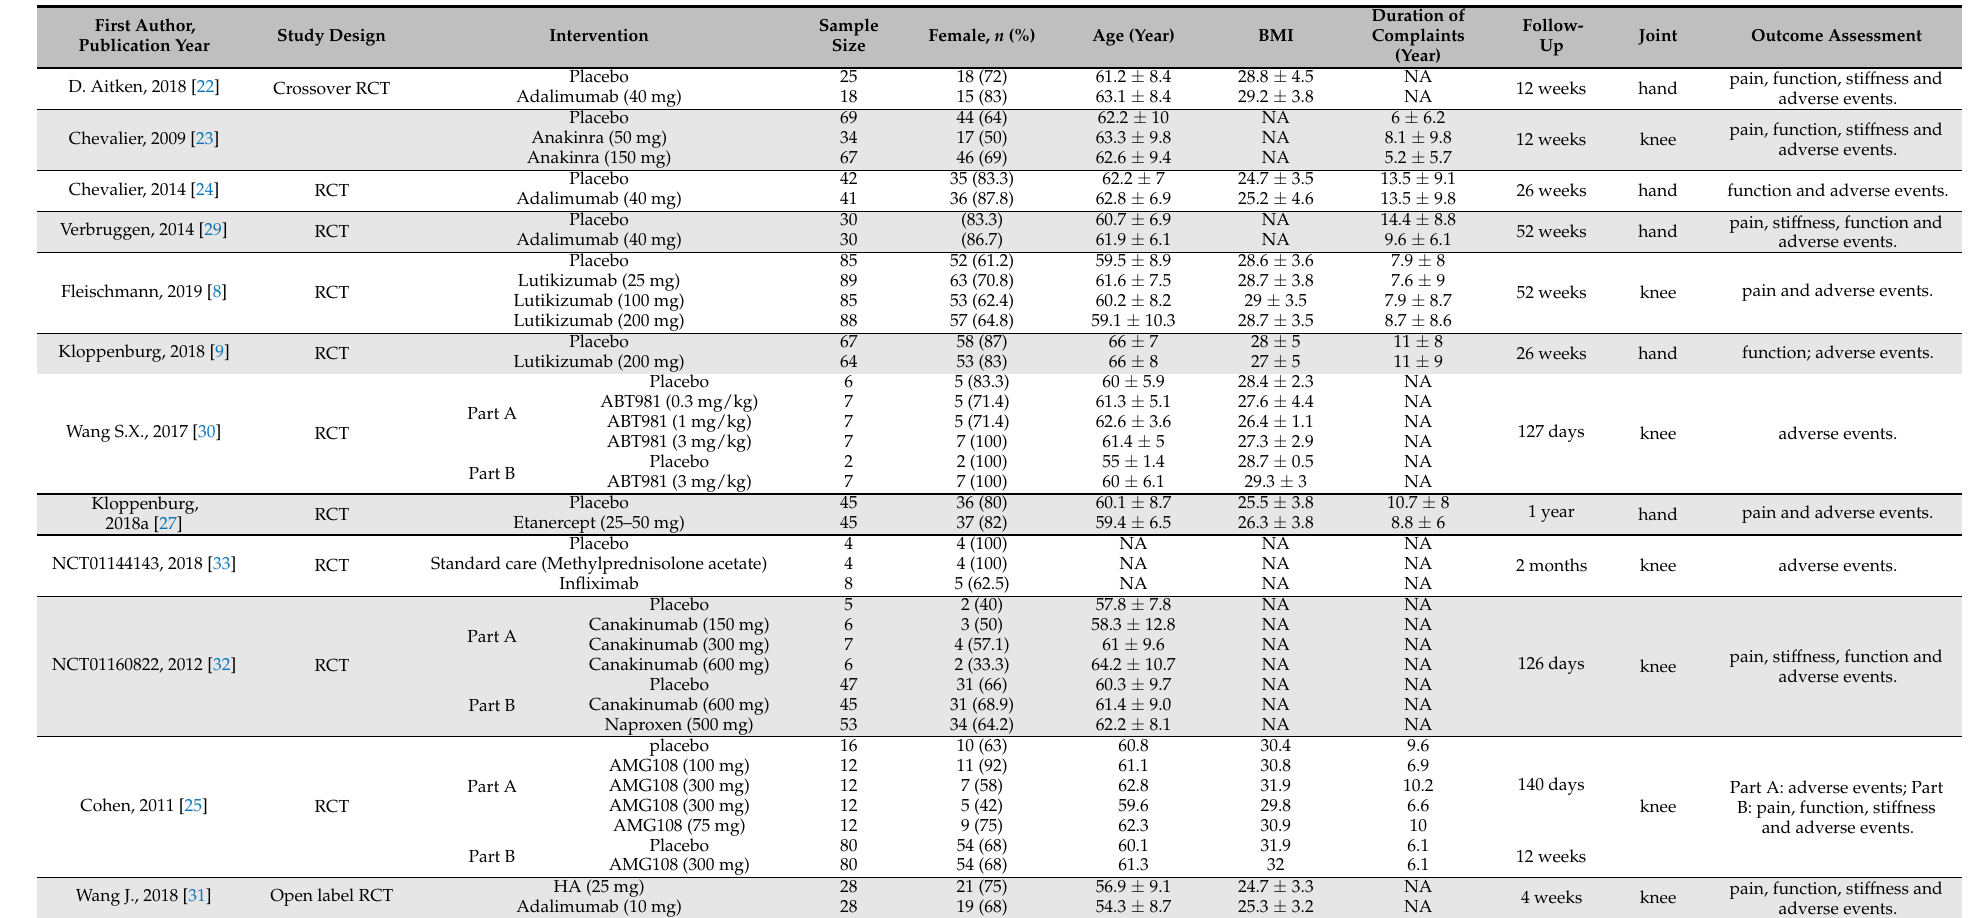
Table 1. Characteristics of included